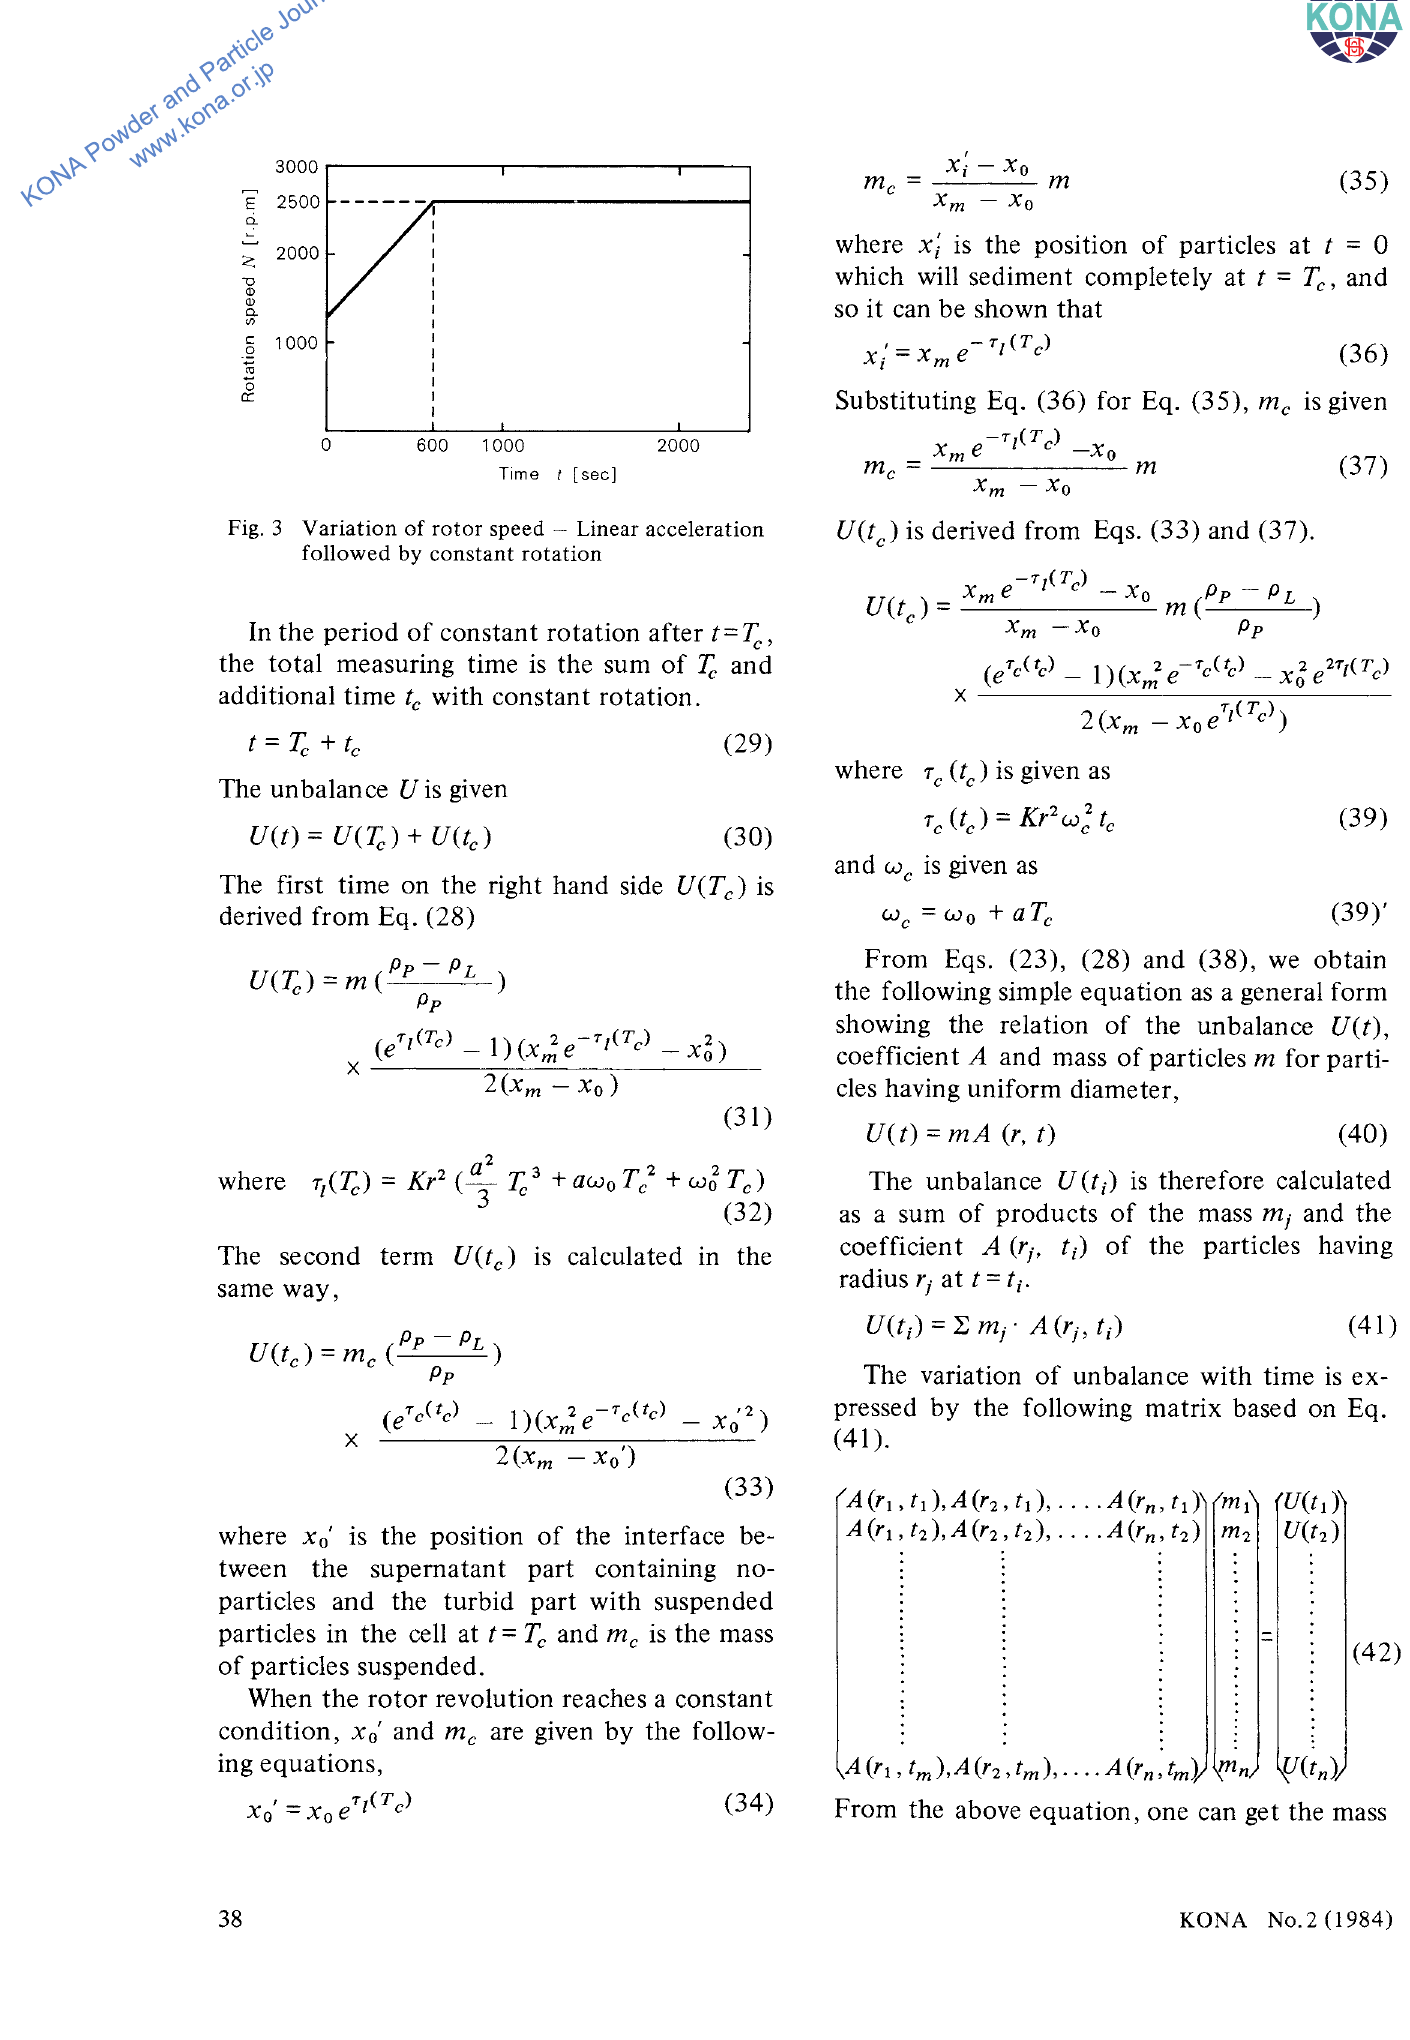
Fig. 3 Variation of rotor speed - Linear acceleration followed by constant